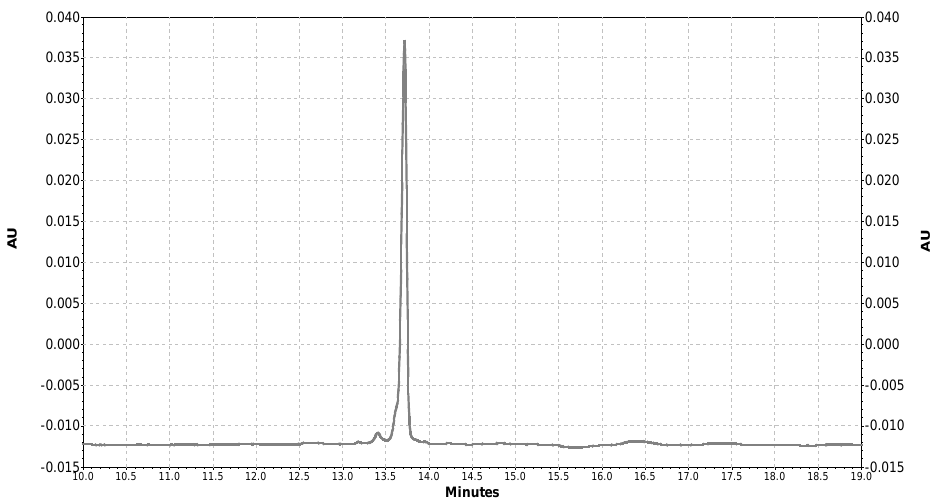
Figure 5 . An electrophoretic diagram of SOD1 separation using CE with a UV detector (200 nm). Two types of QDs with similar dimensions and zeta potentials (green: G-QDs—2.3 nm, − 40.8 mV; yellow: Y-QDs – 3.1 nm, − 42.8 mV) and four different concentrations of SOD1 (1.2 µg/mL; 4 µg/mL; 40 µg/mL; 400 µg/mL) were selected for the analysis. The separation results of Y-QDs and G-QDs were: 21 RFU in 12.1 min and 40 RFU in 11.6 min, respectively (Figure 6).